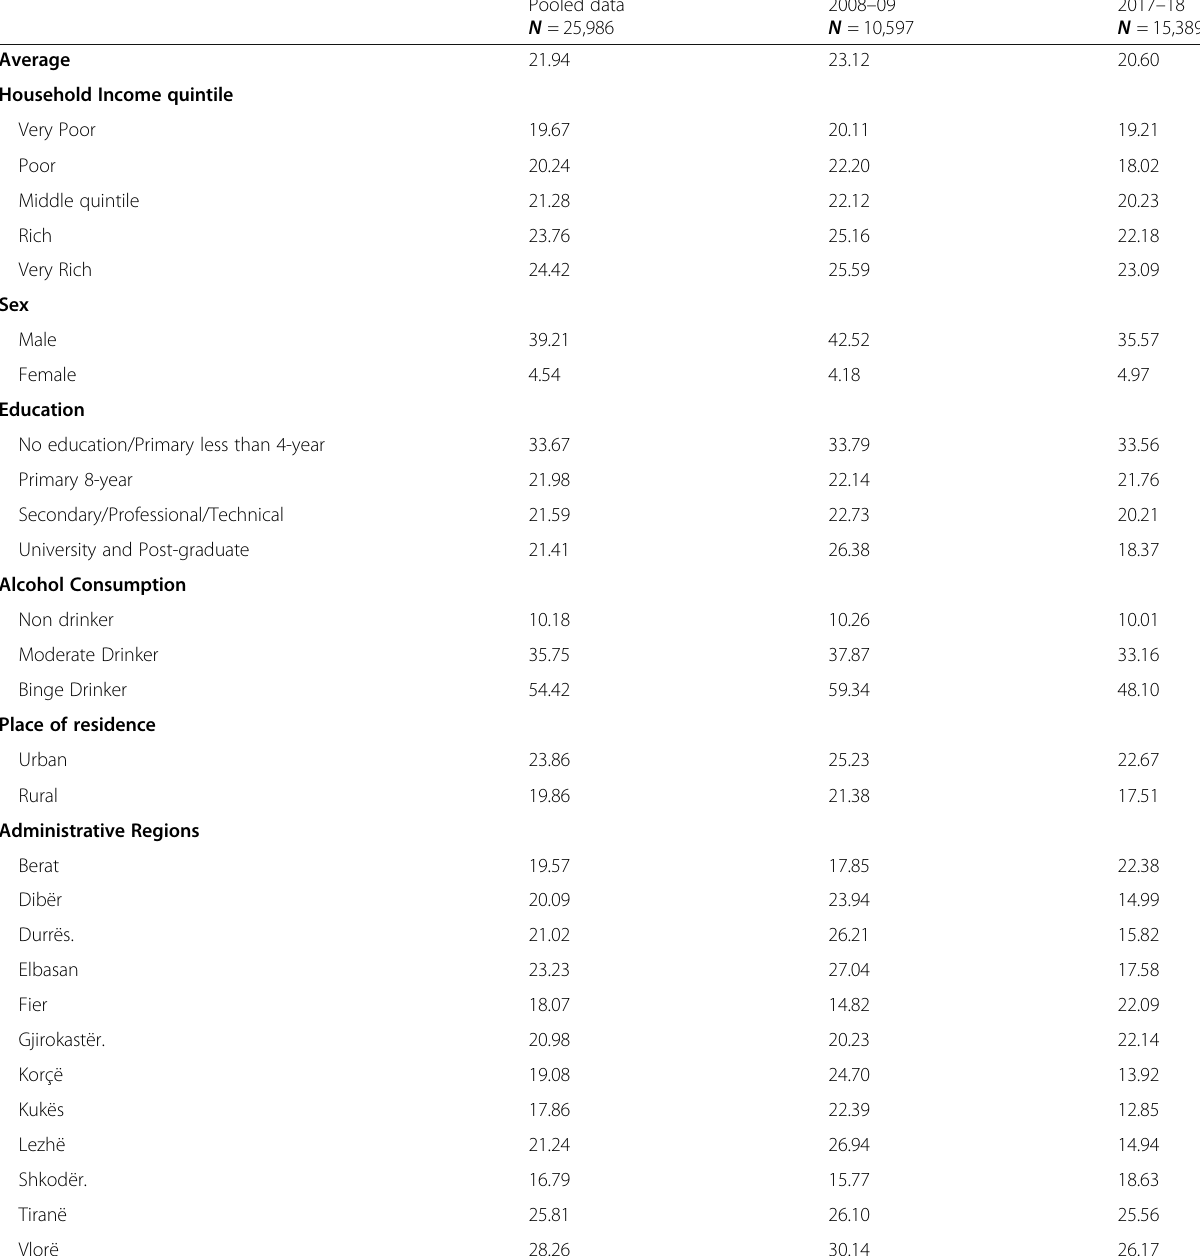
Table 2 Weighted Prevalence of Tobacco smoking by Selected Variables (%)